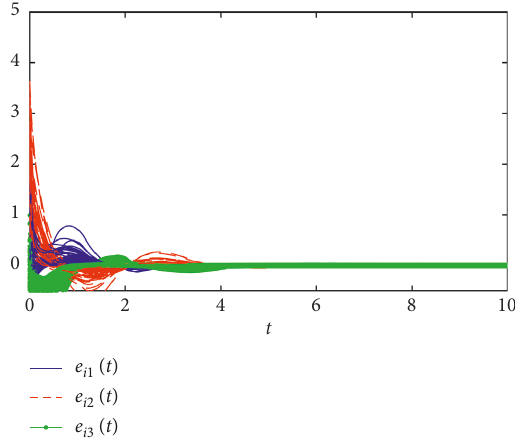
Figure 4: Synchronization error of 13 node networks controlled according to the node selection rules in this